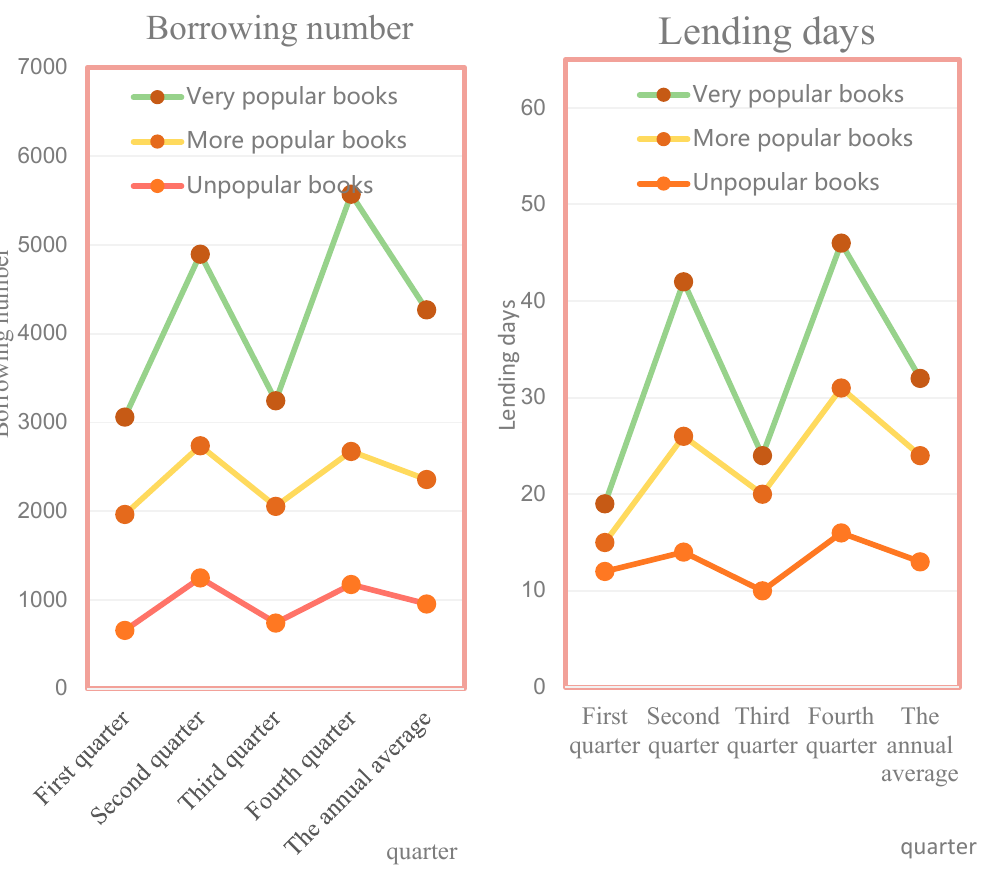
Figure 6. Library lending data graph.